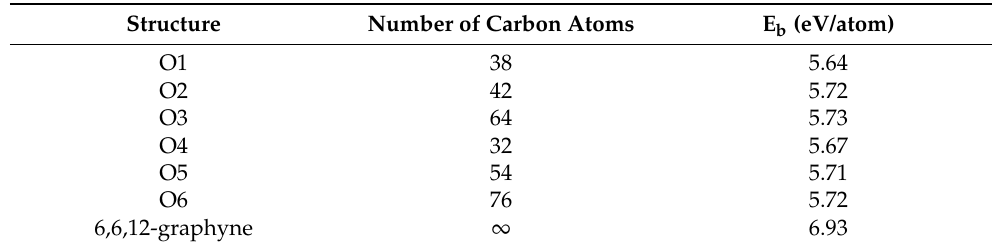
Table 2. Values of the binding energy E b (eV/atom) for the 6,6,12-graphyne crystal and its oligomeric structures O1, O2, O3, O4, O5, and